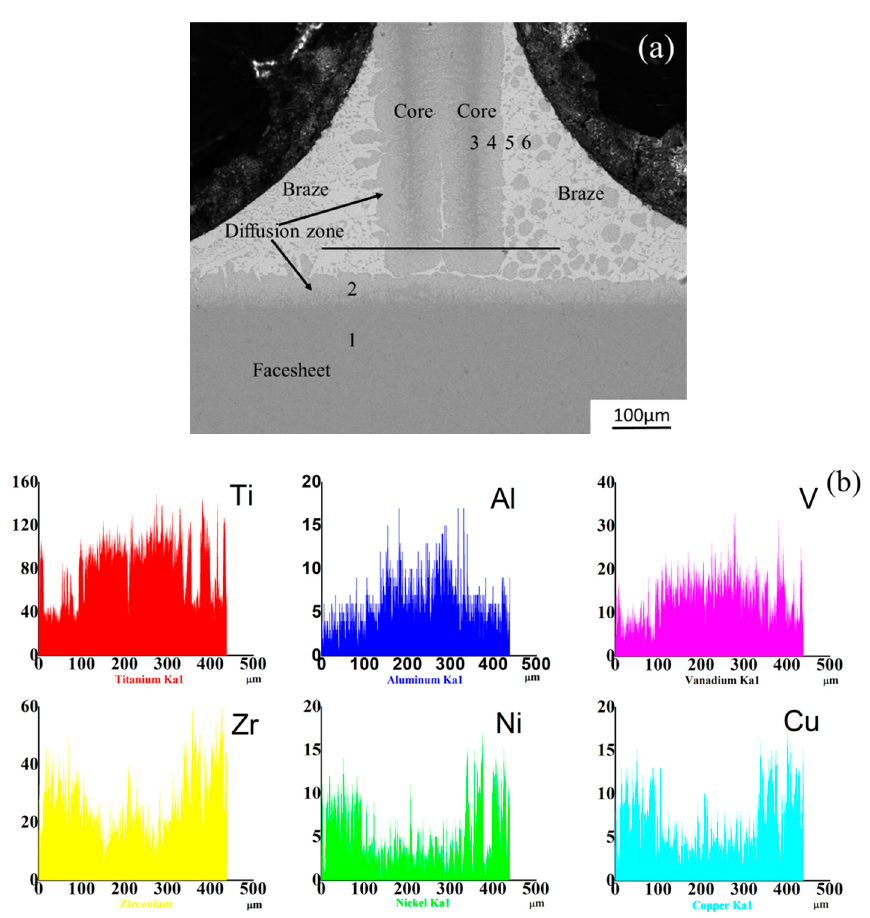
Figure 4. ( a ) The SEM-backscattered electron image (BSE) of the brazed joint. ( b ) Line (arrowed in Figure 6a) scanning of EDS showing the major elements distribution of brazed joint.